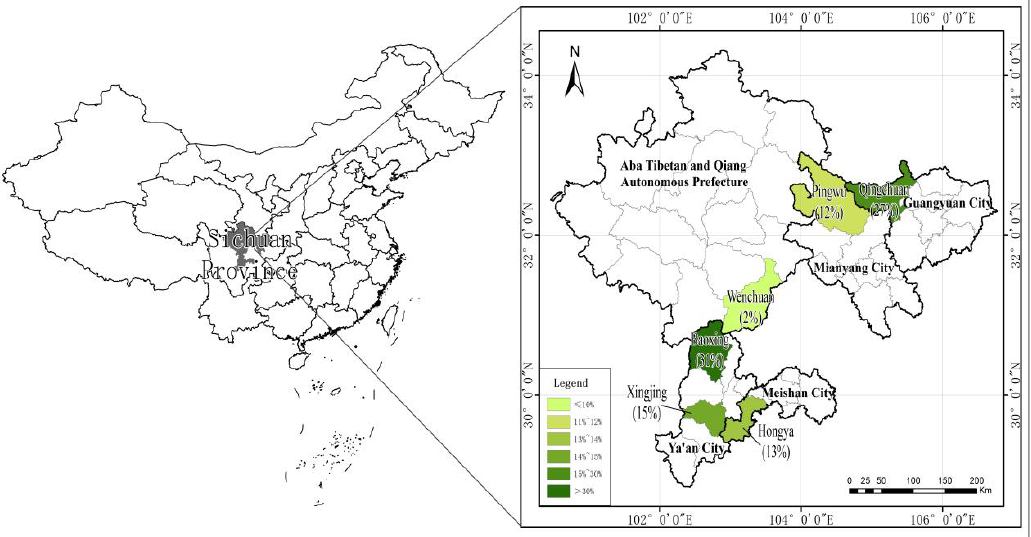
Figure 2. The distribution of surveyed farmers in the county area of Giant Panda National Park in Sichuan Province.